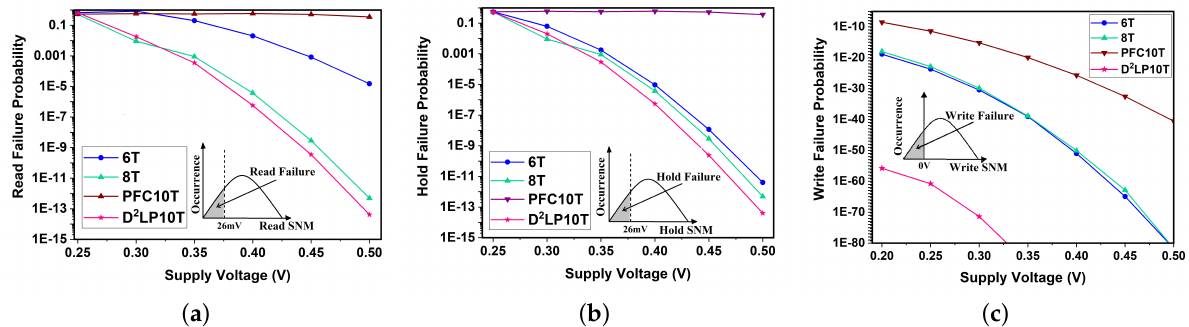
Figure 11. Failure probability with 5000 sample MC simulations: ( a ) read failure, ( b ) hold failure, and ( c ) Write